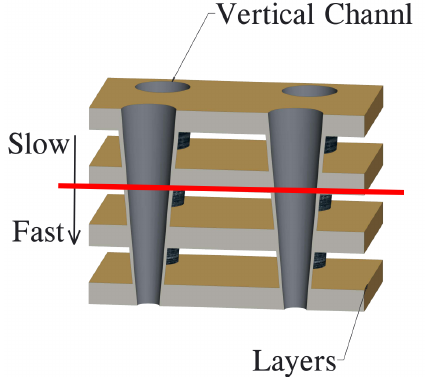
Figure 2. Three-dimensional CT-based